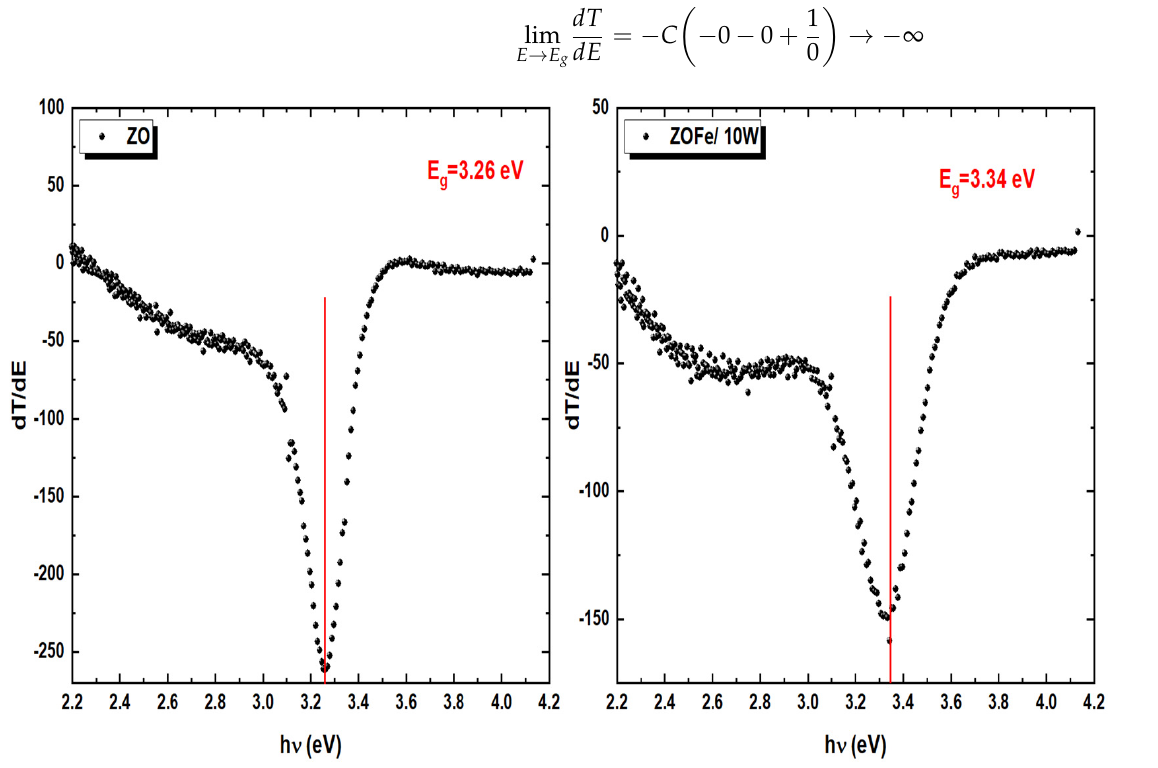
Figure 9. The plots of the derivative of the transmission with respect to energy for the undoped and ZOFe/10 W thin films. (C) The derivative of transmittance (T) against wavelength ( λ )